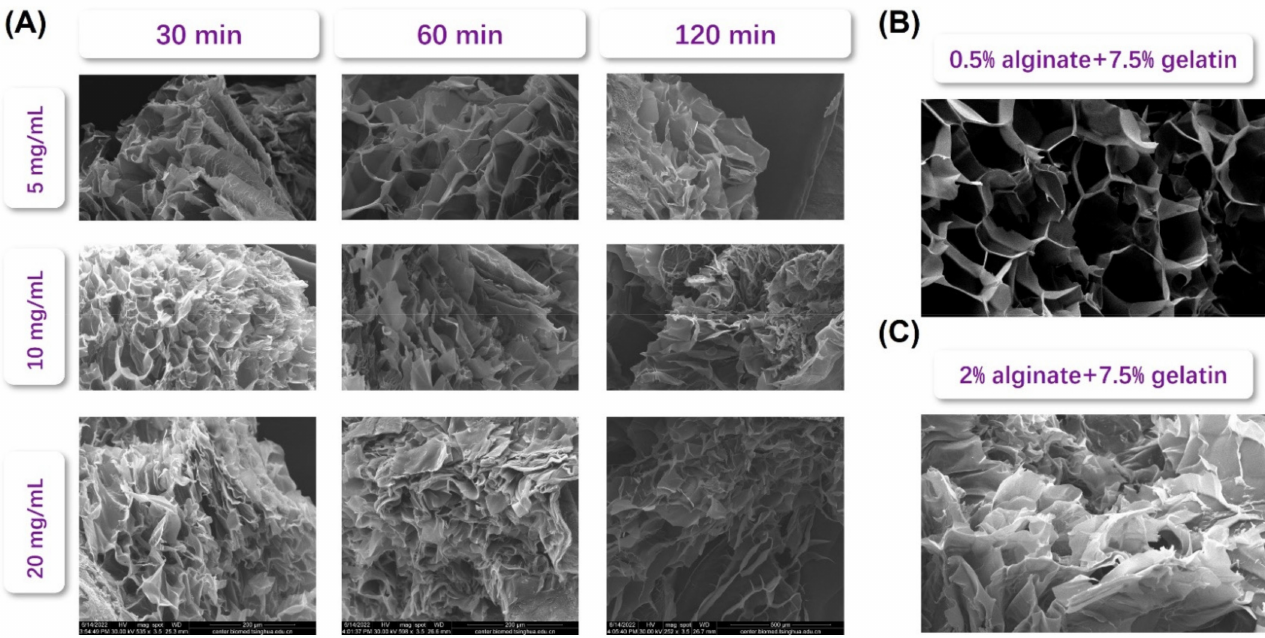
Figure 4. Microscopic structures of alginate–gelatin hydrogel illustrated by SEM images: ( A ) micro- scopic structure of hydrogel made of 1% alginate and 7.5% gelatin, when the TGase concentration varied from 5 to 20 mg/mL, and the TGase reaction time from 30 to 120 min; ( B ) microscopic structure of hydrogel made of 1% alginate and 7.5% gelatin with TGase concentration of 10 mg/mL and TGase reaction time of 120 min. ( C ) microscopic structure of hydrogel made of 2% alginate and 7.5% gelatin with TGase concentration of 10 mg/mL and TGase reaction time of 120